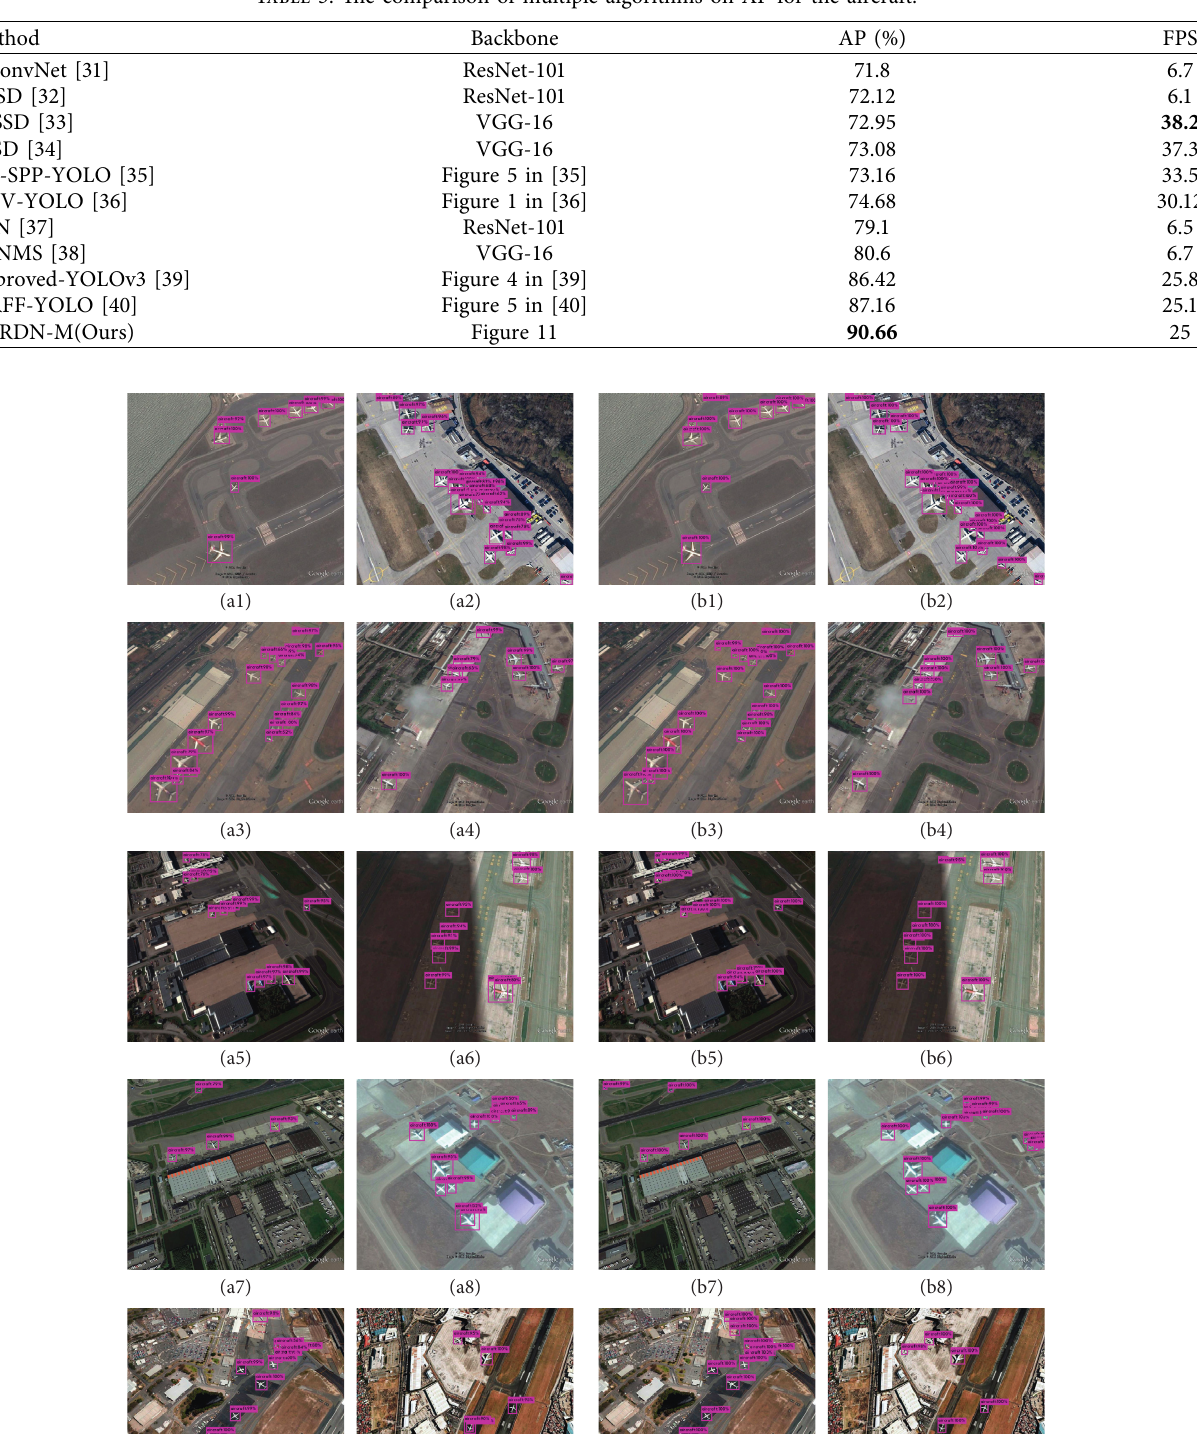
Table 3: The comparison of multiple algorithms on AP for the aircraft.